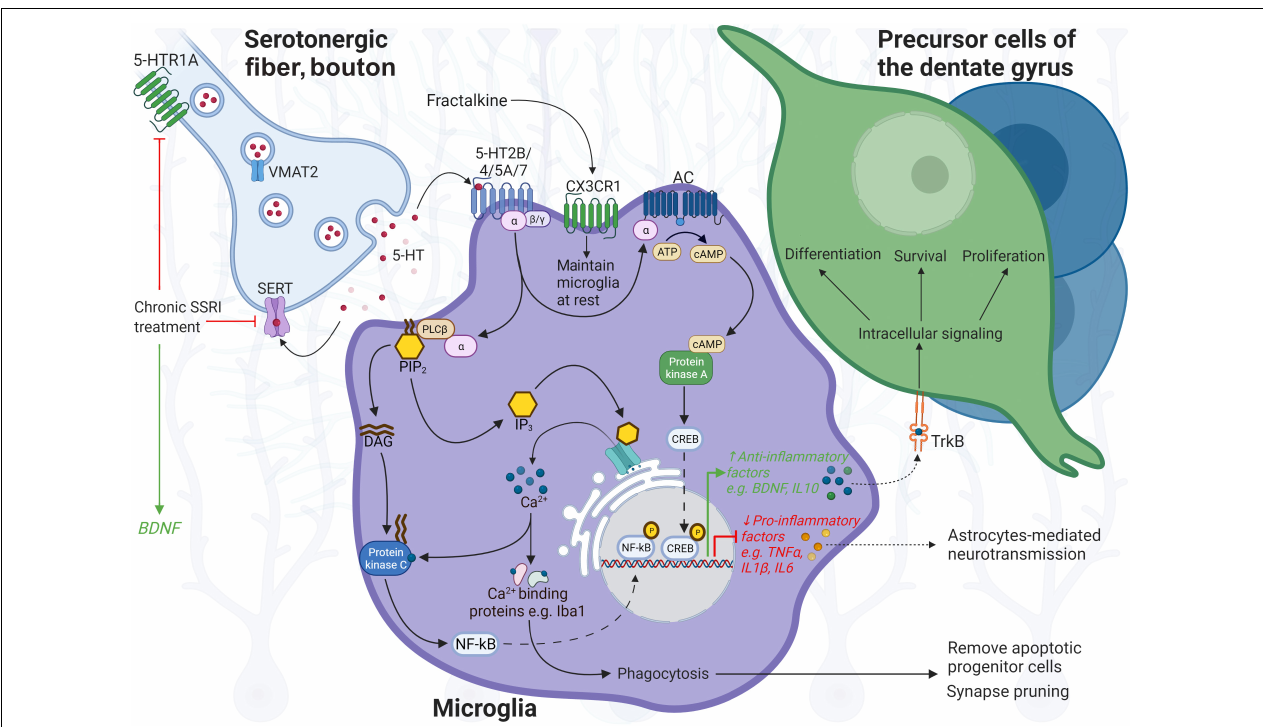
FIGURE 1 | Illustration of microglia function in neuroplasticity of the hippocampus. In close proximity to precursor cells and neurons in the dentate gyrus, resting microglia control the neuronal cell pool by removal of apoptotic progenitor cells and synapse pruning, regulate synaptic plasticity and neural network excitability via ATP, and the release of TNF- α and BDNF, and respond to serotonin (5-HT) neurotransmission. Microglia express 5-HT receptors, most prominently 5-HT2B in response to serotonin, and CX3CR1 in response to neuronal fractalkine/CX3CL1 signaling that allows surveillance of the niche, and communication with neurons to maintain homeostasis. In particular, serotonin neurotransmission can direct microglia function toward neuroprotection or permit the response to inflammation. Dense tracts of serotonergic fibers terminate in the hippocampus. Upon receptor binding, 5-HT2B, coupled to G α q/G11 protein, activates phospholipase C (PLC), which hydrolyzes phosphatidylinositol-4,5-bisphosphonate (PIP2), and mediates cellular effects through increasing levels of inositol triphosphate (IP3) and diacylglycerol (DAG). IP3 promotes Ca2 + excretion from endoplasmic reticulum, which activates Iba-1 involved in motility and phagocytosis activity of microglia, and is affected by 5-HT2B. IP3-induced Ca2 + release can also stimulate phospholipase C (PLC) (likewise via DAG), activating nuclear factor kappa beta (NF-kB) and in turn controls the expression of pro-inflammatory genes, e.g., TNF- α , IL-1 β , and IL-6. Activated by 5-HT4 and 5-HT7 coupled to G α s, the enzyme adenylate cyclase (AC) synthesizes the second messenger elevating cyclic AMP (cAMP) from ATP that activates protein kinase A (PKA); cAMP response element-binding protein (CREB) then controls transcription of genes involved in the anti-inflammatory response, BDNF or IL-10, exerting effects through their receptors, TrkB and IL-10R, located on precursor cells (TrkB) and neurons. 5-HT5A interactions with G α i protein inhibit AC and downstream cascades. Upon harmful stimuli, microglia secrete pro-inflammatory cytokines, TNF- α , IL-1 β , and IL-6, and actively remove cell debris. In prolonged neuroinflammation, microglia–neuron communication is altered, leading to neurodegeneration and cognitive deficits. In response to SSRIs, targeting SERT and presynaptic 5-HT1A auto-receptors on serotonergic neurons, 5-HT availability is enhanced in the synaptic cleft, which may also modulate BDNF levels. Increased release of pro-inflammatory cytokines may be counter-balanced by increased 5-HT levels upon SERT inhibition through fluoxetine—having anti-inflammatory properties. 5-HT, 5-hydroxytryptamine; BDNF, brain-derived neurotrophic factor and its receptor TrkB (tropomyosin-related kinase receptor B); Iba-1, ionized calcium binding adaptor molecule 1; SERT, serotonin transporter; TNF,